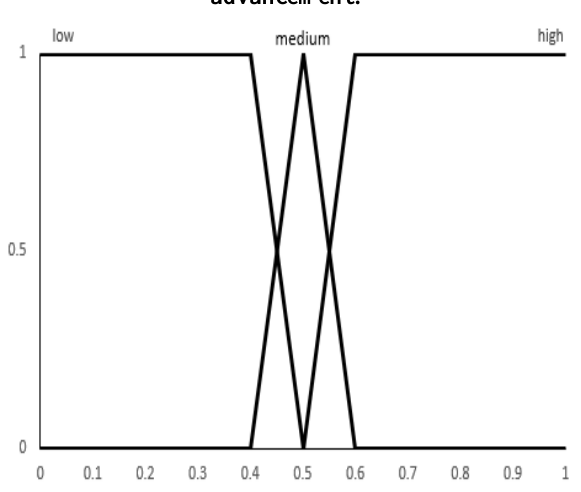
Figure 4. Membership function for local density.